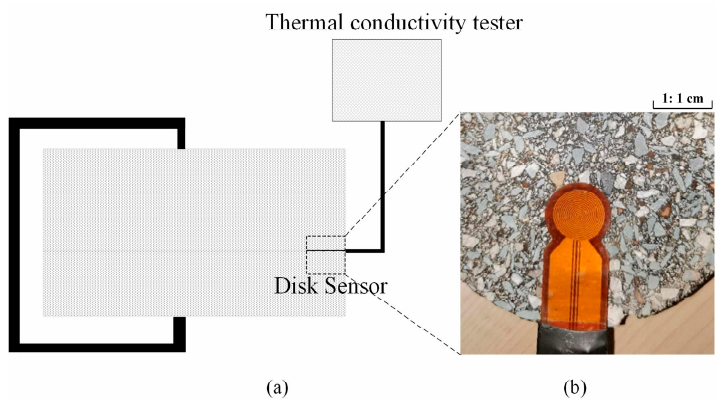
Figure 7. The TPS method schematic: ( a ) the transient plane source method; ( b ) enlarged view of the disk